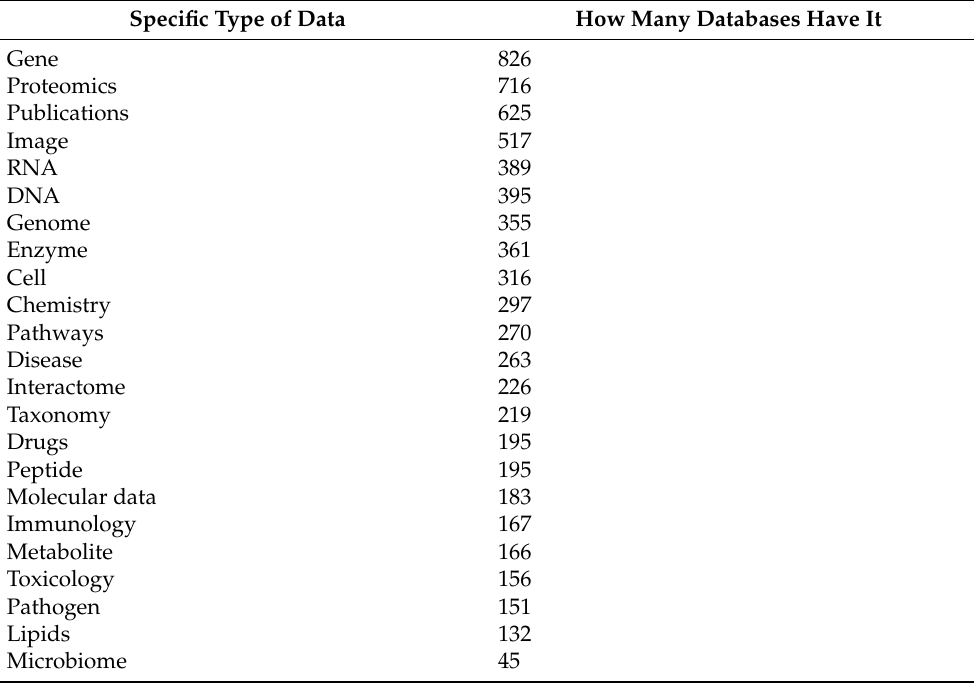
Table 1. Keywords yielded by a search on “Properties” in